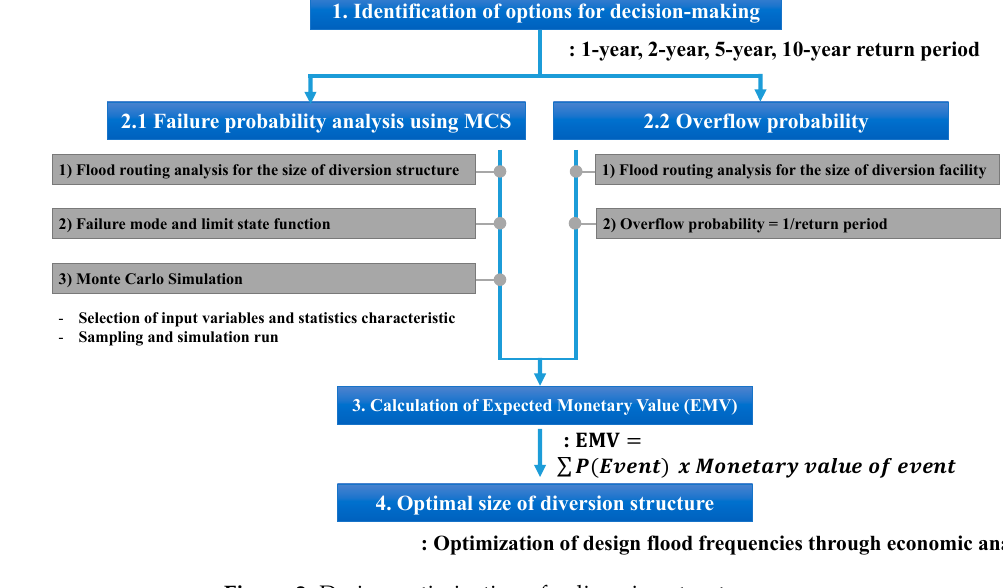
Figure 2. Design optimization of a diversion structure.